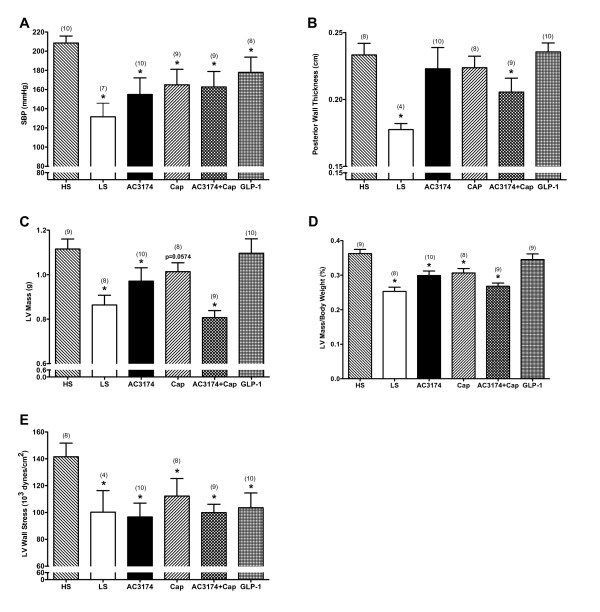
Cardiovascular changes after 4 weeks of treatment demonstrated beneficial effects of AC3174. (A) Systolic blood pressure. P = 0.0226 for one-way ANOVA. The pooled-over-time means of the low salt and AC3174 groups were significantly different from the high salt group (P ≤ 0.05). (B) Posterior left ventricular wall thickness. P = 0.0030 for one-way ANOVA. The pooled-over-time mean of the low salt group was significantly different from the high salt group (P ≤ 0.05). (C) Left ventricular heart mass. P = 0.0002 for one-way ANOVA. The pooled-over-time means of the low salt and AC3174 plus captopril groups were significantly different from the high salt group (P ≤ 0.05). (D) Left ventricular heart mass as a percentage of total body weight. P < 0.0001 for one-way ANOVA. The pooled-over-time means for all treatment groups, except GLP-1, were significantly different from the high salt group (P ≤ 0.05). (E) Left ventricular heart wall stress. P = 0.0512 for one-way ANOVA. The pooled-over-time means of the AC3174 and AC3174 plus captopril groups were significantly different from the high salt group (P ≤ 0.05). There were 10 rats per group at beginning of treatment. N = 3 to 10 rats per group at end of treatment actually shown. *P < 0.05 versus high salt diet alone. Mean ± SEM.